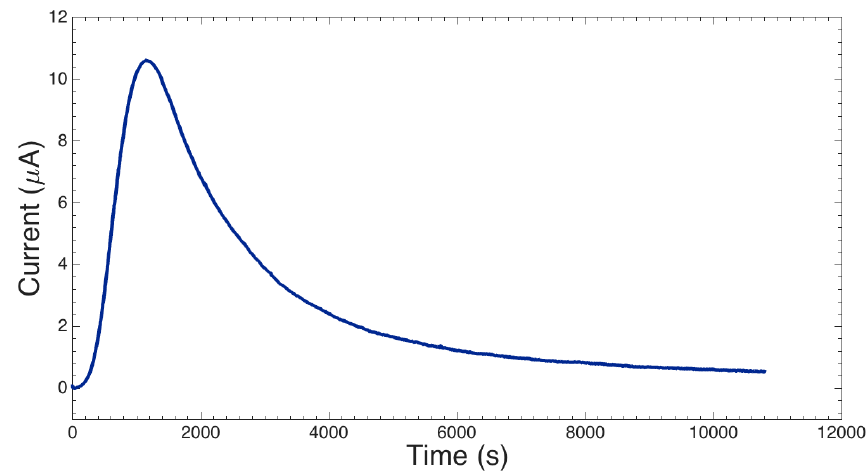
Figure 7. Plot showing the anodic bonding current over an extended period of 3 h (10,800 s). Bonding conditions were 225 V at 250 C.